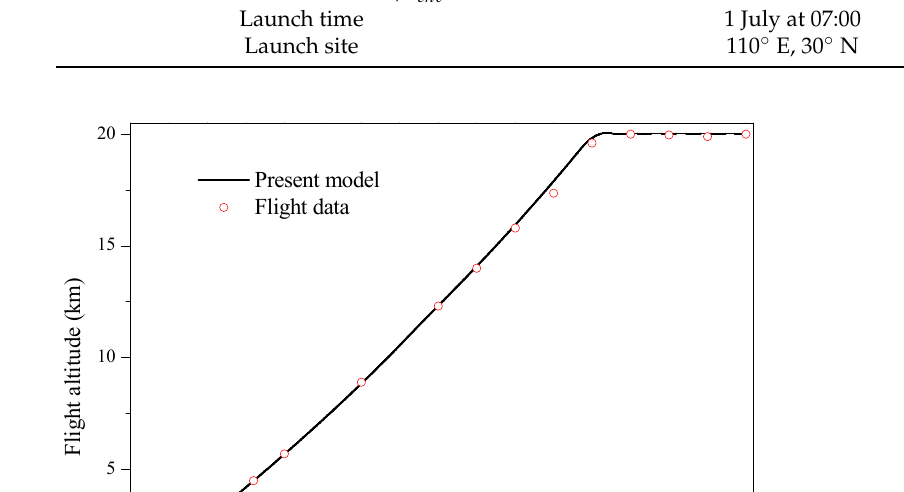
Figure 5. Comparison between the predicted data and the experimental data (flight altitude).